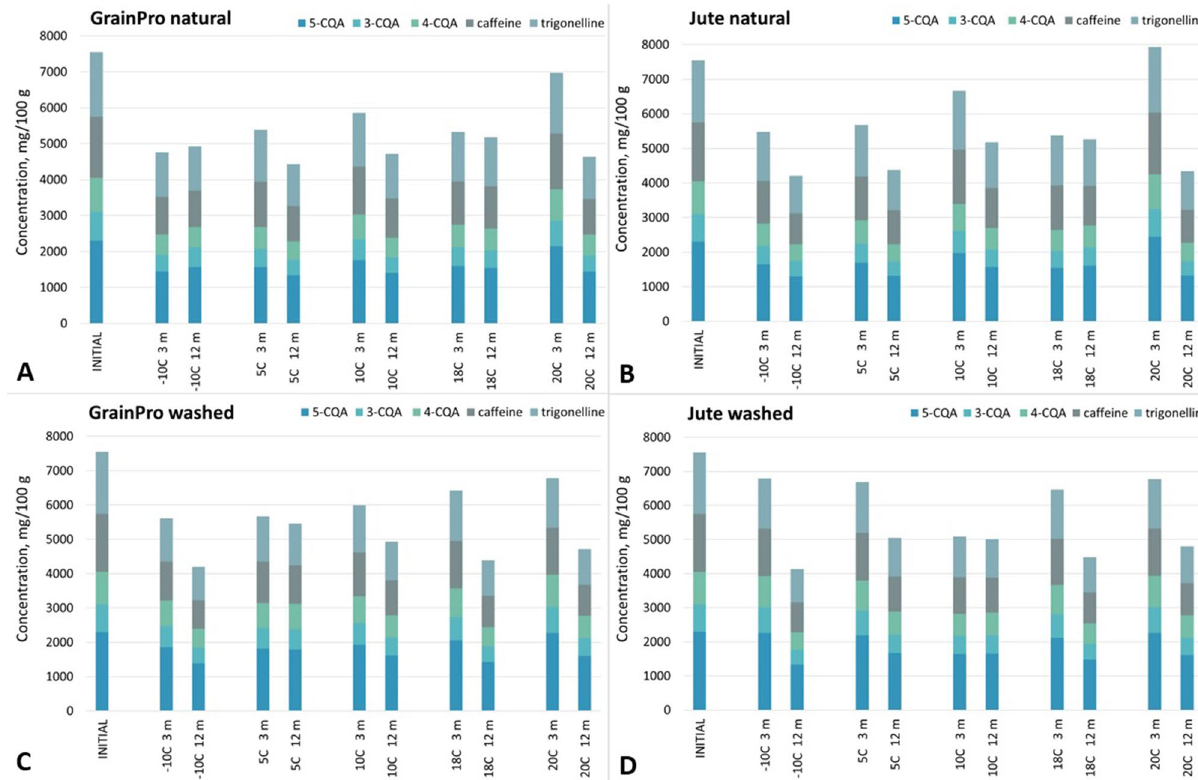
Figure 3. Comparison of compound concentrations (in mg/100 g) found in the coffee samples roasted from washed ( C , D ) and natural ( A , B ) processed green beans stored in GrainPro ( A , C ) and jute ( B , D ) bags for 3 and 12 months relative to the initial values of the coffees before storage. 5-CQA (5-O-caffeoylquinic acid), 4-CQA (4-O-caffeoylquinic acid), 3-CQA (3-O-caffeoylquinic acid). Mean values (n =